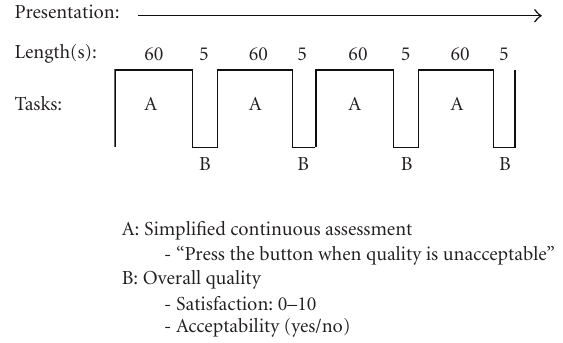
Figure 2: Experimental setup: simplified continuous assessment and retrospective ratings of quality and acceptance.